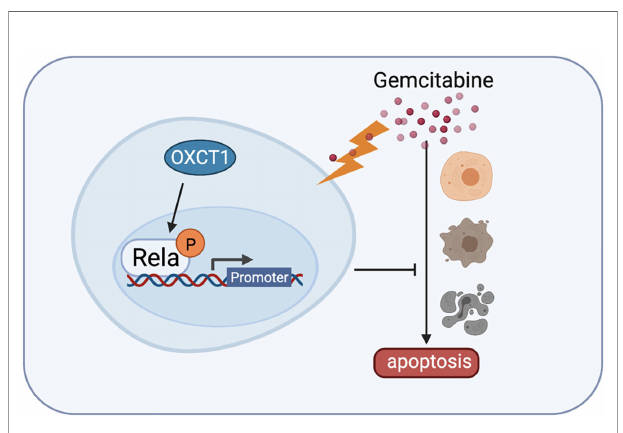
FIGURE 6 | Detailed mechanism of gemcitabine resistance in PDAC induced by OXCT1. Schematic diagram shows that OXCT1 can signi fi cantly enhance the resistance to gemcitabine by activating the NF- k B signaling pathway in PDAC cells, thereby inhibit cell apoptosis, and fi nally promote the occurrence and progression of